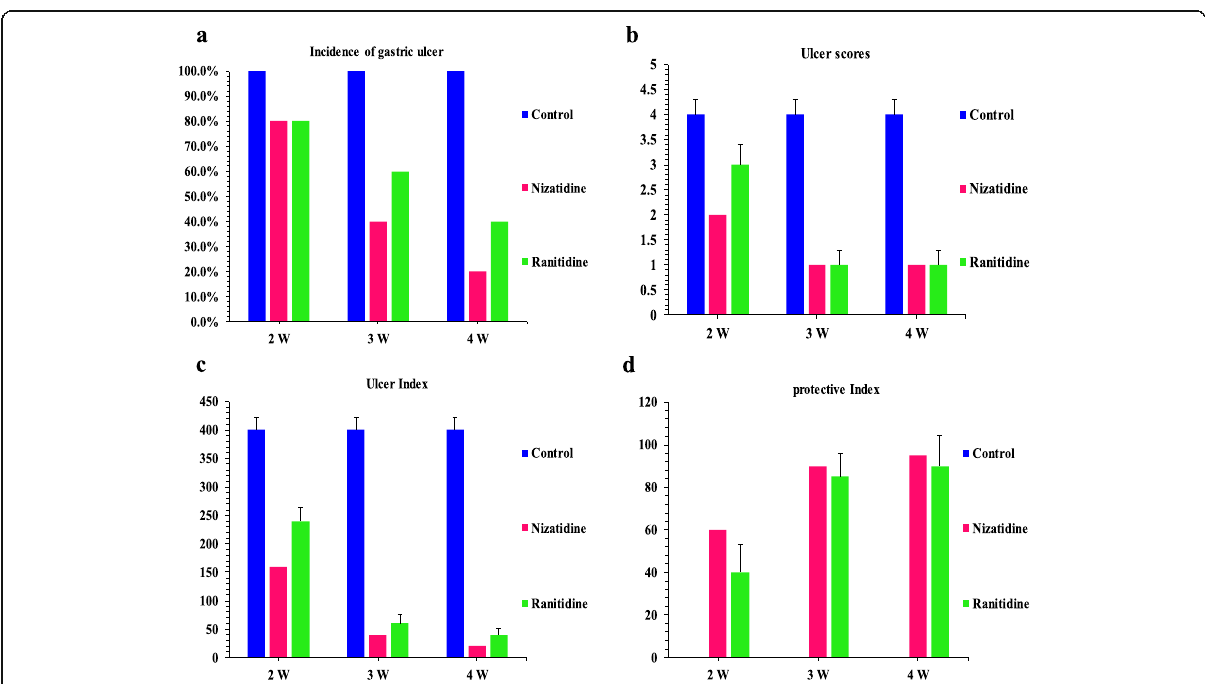
Fig. 7 a Effects of oral administration of nizatidine, ranitidine (27 mg/kg b. wt.) given once a day for 4 weeks on incidence of gastric ulceration in rats administrated NSAIDs (piroxicam (5 mg/kg) followed 60 min later by paracetamol (80 mg/kg) as single dosage). b Effects of oral administration of nizatidine and ranitidine (27 mg/kg b. wt.) given once a day for 4 weeks on mean ulcer score in rats administrated NSAIDs ( piroxicam (5 mg/kg) followed 60 min later by paracetamol (80 mg/kg) as single dosage). c Effects of oral administration of nizatidine, ranitidine (27 mg/kg b. wt.) given once a day for 4 weeks on ulcer index in rats administrated NSAIDs (piroxicam (5 mg/kg) followed 60 min later by paracetamol (80 mg/kg) as single dosage). d Effects of oral administration of nizatidine, ranitidine (27 mg/kg b. wt.) given once a day for 4 weeks on preventive index (%) in rats administrated NSAIDs (piroxicam (5 mg/kg) followed 60 min later by paracetamol (80 mg/kg) as single